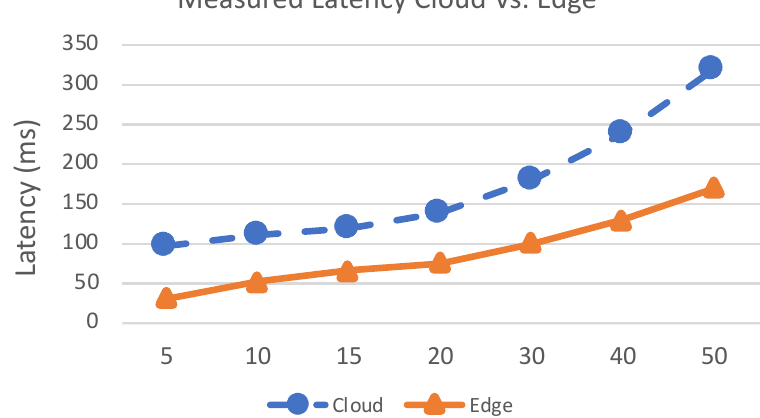
Figure 13. Measured latency on edge and cloud system configuration.